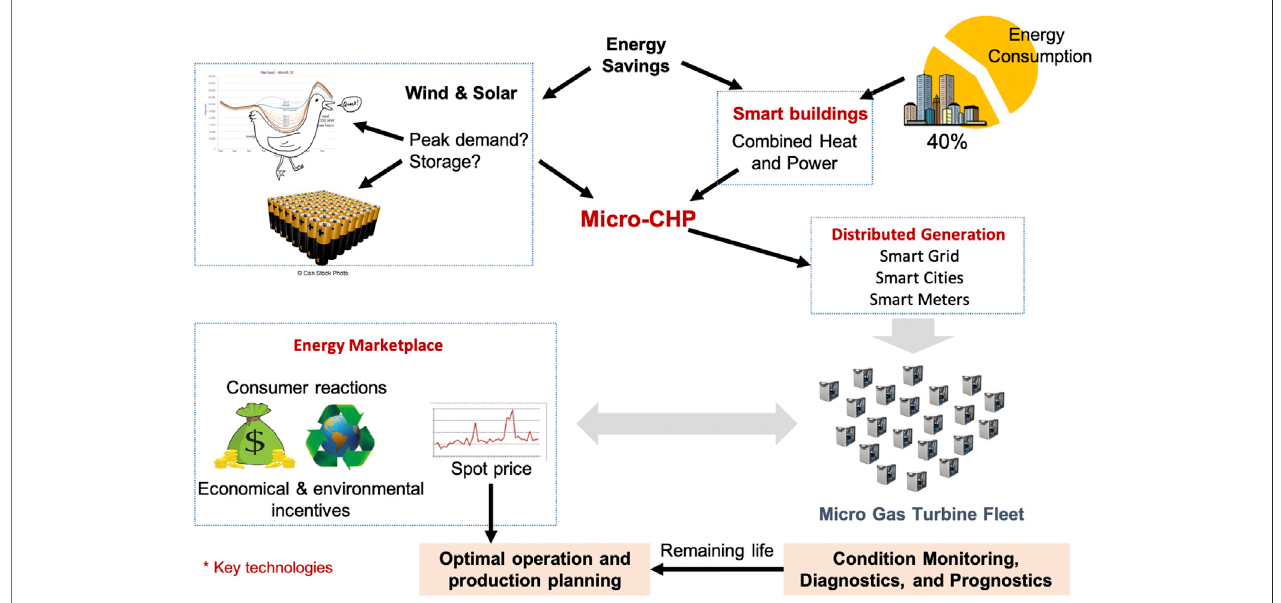
FIGURE 2 | The micro gas turbine fl eet concept for distributed generation of combined heat and power (CHP).